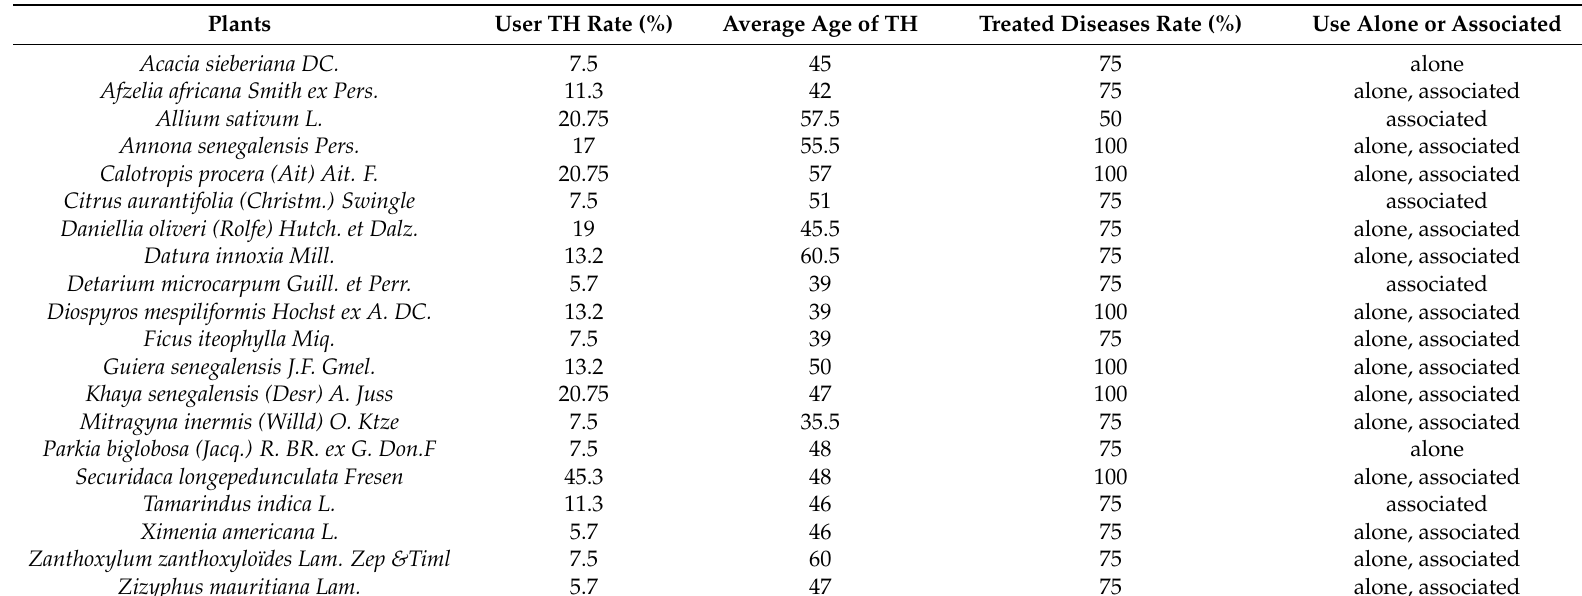
Table 2. Main plants used, rate and age of TH user, rate of treated diseases and type of use. Plants User TH Rate (%) Average Age of TH Treated Diseases Rate (%) Use Alone or Associated Acacia sieberiana DC. 7.5 45 75 alone Afzelia africana Smith ex Pers. 11.3 42 75 alone, associated Allium sativum L. 20.75 57.5 50 associated Annona senegalensis Pers. 17 55.5 100 alone, associated Calotropis procera (Ait) Ait. F. 20.75 57 100 alone, associated Citrus aurantifolia (Christm.) Swingle 7.5 51 75 associated Daniellia oliveri (Rolfe) Hutch. et Dalz. 19 45.5 75 alone, associated Datura innoxia Mill. 13.2 60.5 75 alone, associated Detarium microcarpum Guill. et Perr. 5.7 39 75 associated Diospyros mespiliformis Hochst ex A. DC. 13.2 39 100 alone, associated Ficus iteophylla Miq. 7.5 39 75 alone, associated Guiera senegalensis J.F. Gmel. 13.2 50 100 alone, associated Khaya senegalensis (Desr) A. Juss 20.75 47 100 alone, associated Mitragyna inermis (Willd) O. Ktze 7.5 35.5 75 alone, associated Parkia biglobosa (Jacq.) R. BR. ex G. Don.F 7.5 48 75 alone Securidaca longepedunculata Fresen 45.3 48 100 alone, associated Tamarindus indica L. 11.3 46 75 associated Ximenia americana L. 5.7 46 75 alone, associated Zanthoxylum zanthoxyloïdes Lam. Zep &Timl 7.5 60 75 alone, associated Zizyphus mauritiana Lam. 5.7 47 75 alone,